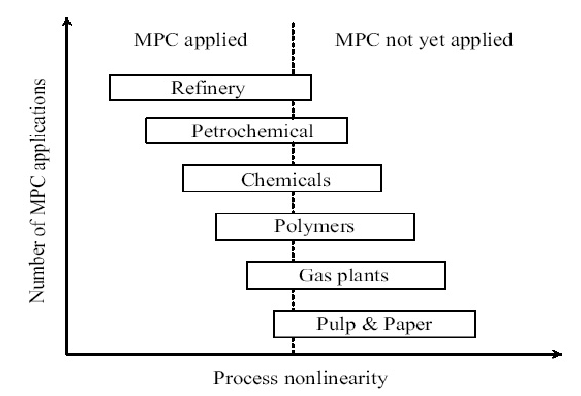
Fig. 1: Industrial applications of MPC